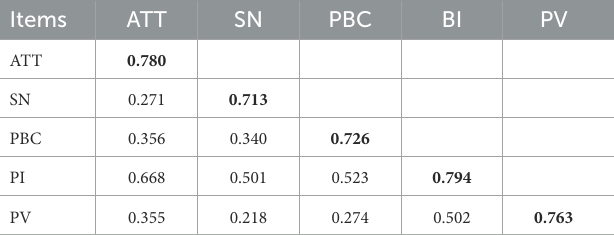
TABLE 4 Distinguishing validity test of